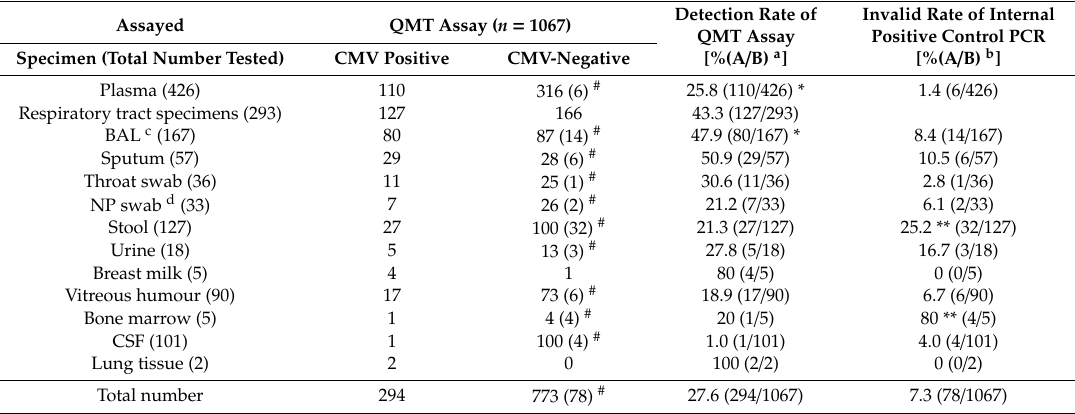
Table 2. The Performance of QMT assay with various clinical